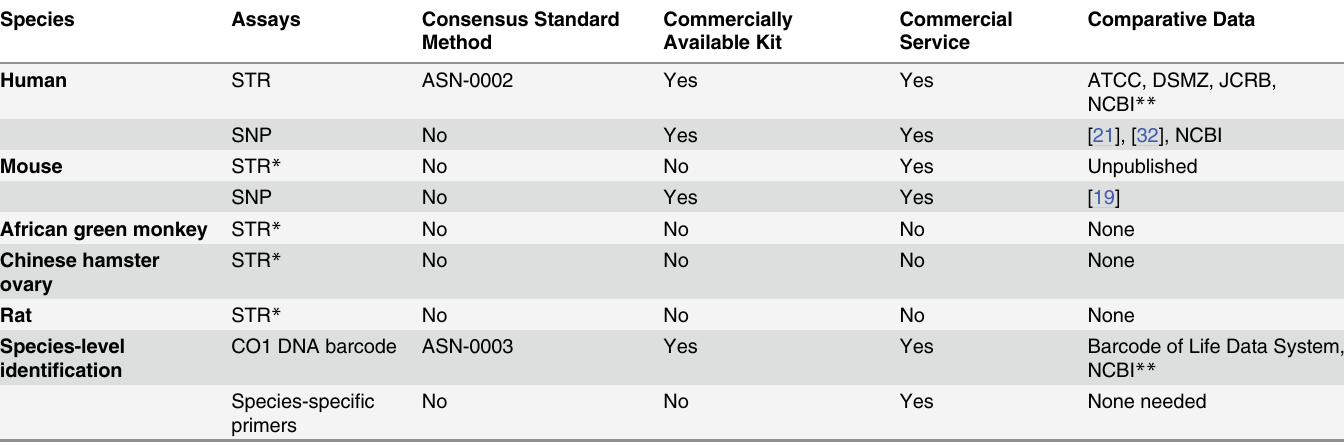
Table 2. Current status of SNP, STR, and DNA barcode technologies as standard methods for assessing the identity of cell lines from different species. Species Assays